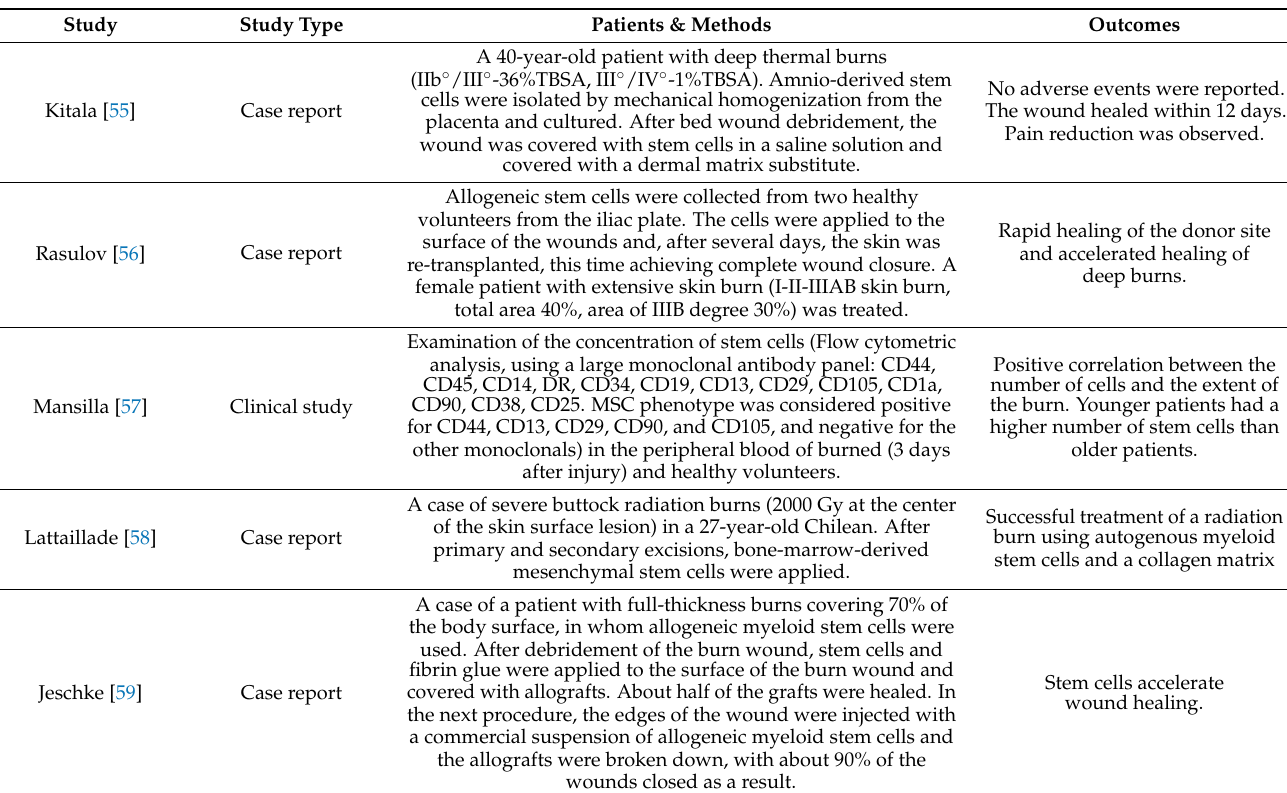
Table 2. Human studies on stem cells in burn wound